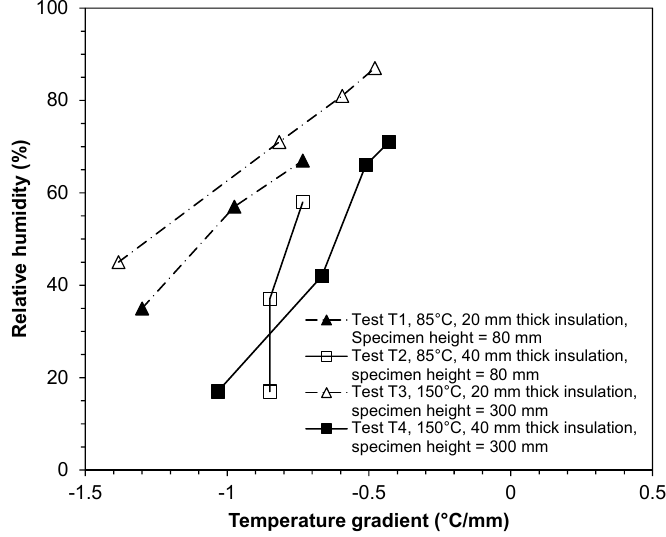
Figure 7. Temperature gradient versus relative humidity plot for non-isothermal tests at 85 °C and 150 °C.